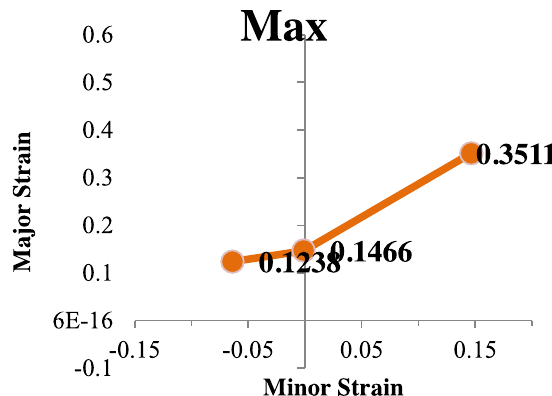
Fig. 18. Forming limit diagram for cube (cid:4) numerical